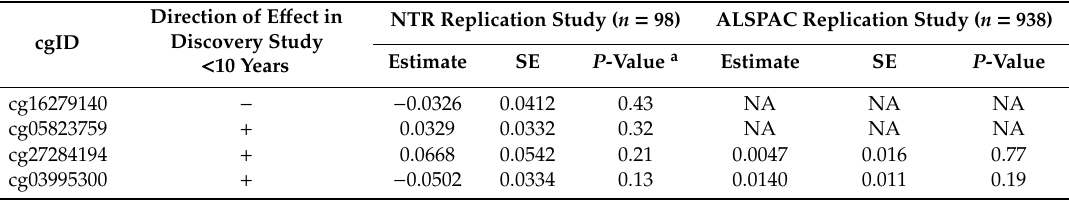
Table 3. Summary of association between breastfeeding and significant in the discovery study CpGs in replication.